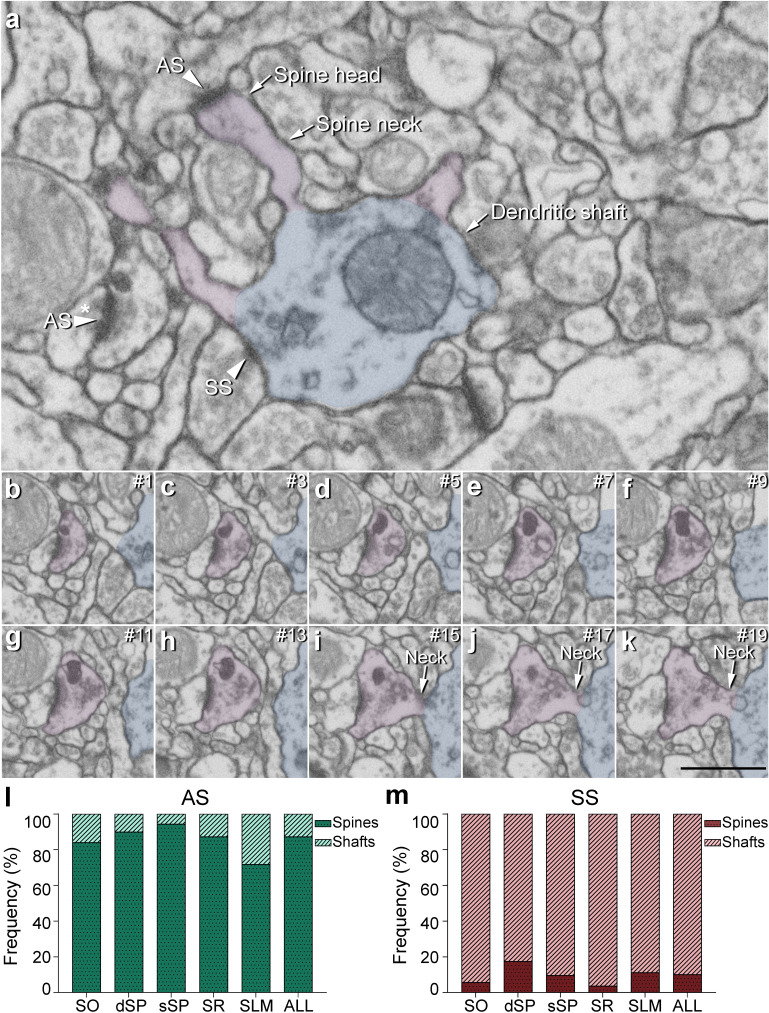
Postsynaptic target identification in serial electron microscopy images.(a) A crop from an electron microscopy section obtained by FIB/SEM to illustrate a dendritic shaft (blue) with three dendritic spines (purple) emerging from the shaft (the neck and head have been indicated in one of the spines). A symmetric synapse (SS) on the dendritic shaft is pointed out with an arrowhead. An axospinous asymmetric synapse (AS) (marked with an arrowhead) is established on the head of one of the spines. Another AS is indicated (arrowhead with asterisk); however, the nature of the postsynaptic element where the synapse is established cannot be distinguished in a single section. (b−k) Crops from electron microscopy serial sections to illustrate the nature of the postsynaptic element of the AS (arrowhead with asterisk) in (a). By following up from this AS through the stack of images (the number of the section is indicated in the top right hand corner of each section; 40 nm thickness separation between images), a dendritic spine (purple), whose neck has been labeled emerging from the dendritic shaft (blue), can be unequivocally identified. (l, m) The percentage of axospinous and axodendritic synapses within the AS (l) and SS (m) populations in all layers of CA1. SO: stratum oriens; dSP: deep stratum pyramidale; sSP: superficial stratum pyramidale; SR: stratum radiatum; SLM: stratum lacunosum-moleculare. Scale bar in (k) corresponds to: 1 µm in (a); 500 nm in (b−k).